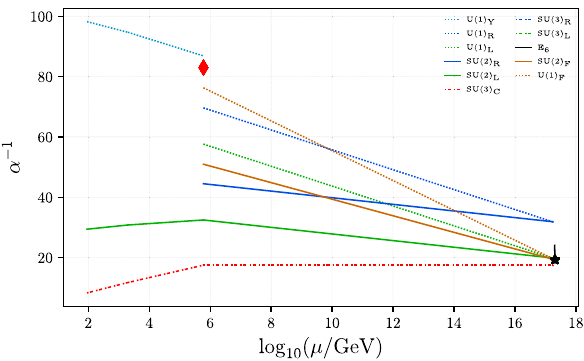
Fig. 10 Running of the gauge couplings in the SHUT model for the second point detailed in Table 8. This example was chosen as a rep- resentative solution of the scenarios with gauge couplings as close to universality as possible after E 6 is broken. In particular we have α ( M ) ∼ α ( M ) ∼ α ( M ) (cid:2) α ( M ) . The red diamond and the L 6 C 6 F 6 R 6 black star have the same meaning as in Fig.